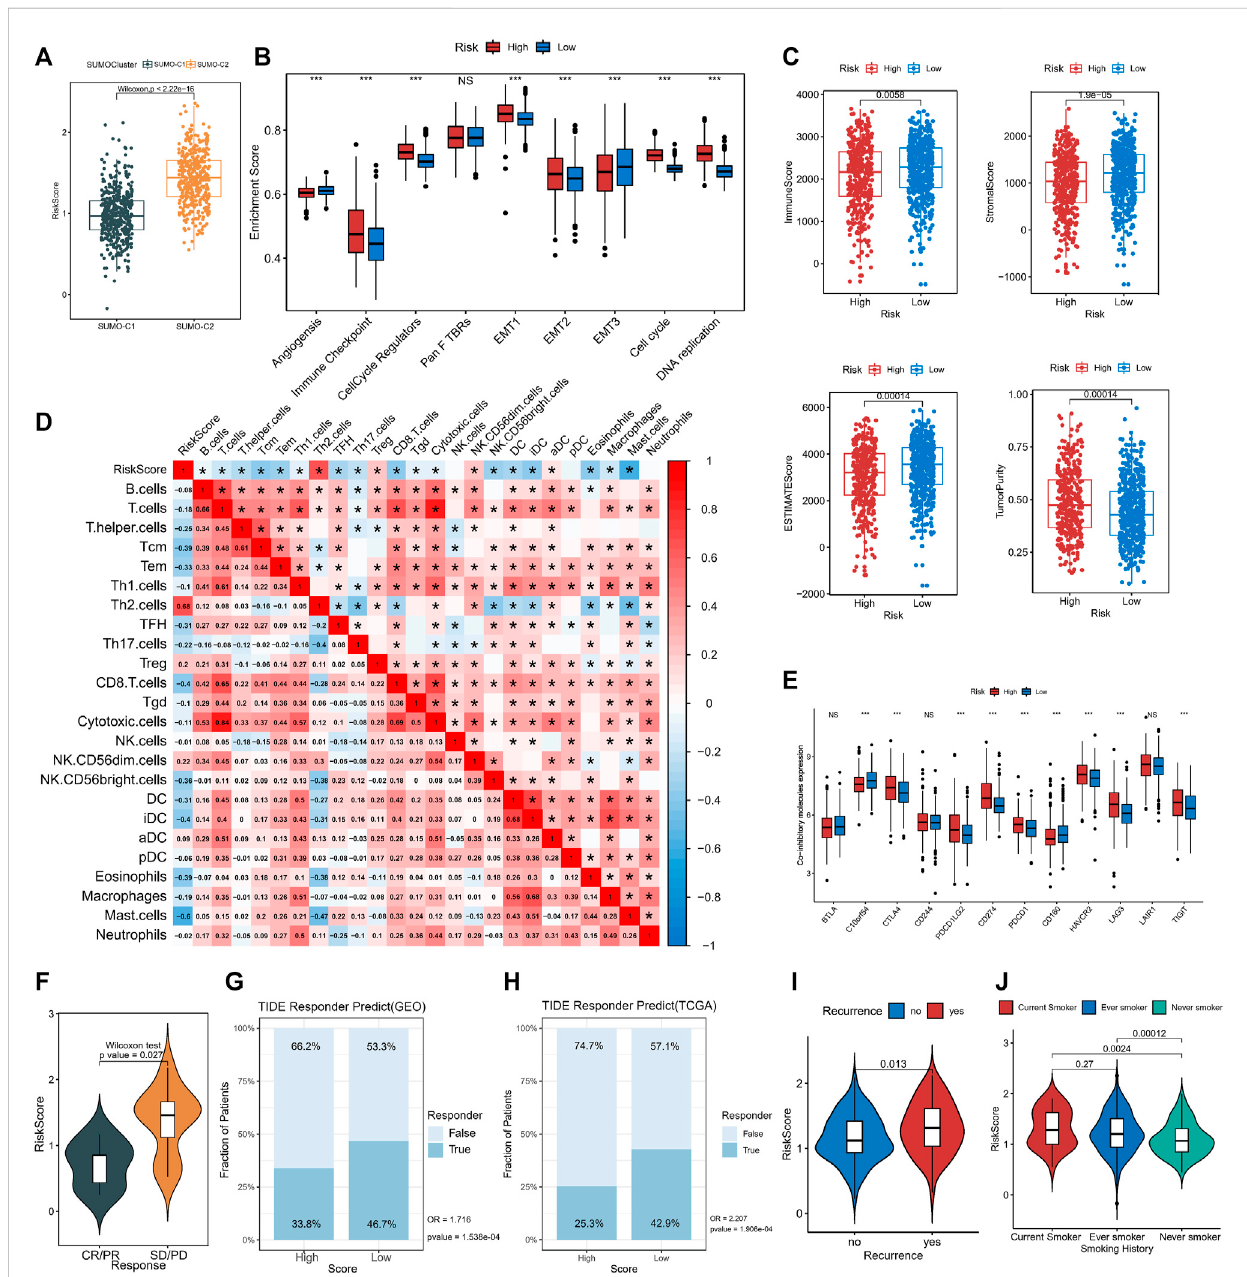
FIGURE 7 The association of SUMOylation score with tumor microenvironment and clinical characteristics. (A) The Wilcoxon test for signi fi cant differences in SUMOylation scoresbetweenthetwoSUMOylation patterns. (B) Oncogenicmatrixmicroenvironmentdifferencesbetweenhigh-andlow-SUMOylation score. (C) Signi fi cant differences in ImmuneScore, StromalScore, ESTIMATEScore, and TumorPurity between different SUMOylation scores. (D) The correlation between SUMOylation score and immune cell in fi ltration. (E) Analysis of differential expression of co-inhibitory molecules between high- and low-SUMOylation score. (F) Comparison of SUMOylation scores between groups with and without immunotherapy response. Prediction of immunotherapy response in high and low-risk groups in GEO cohort (G) and TCGA cohort (H) based on TIDE algorithm. Association of lung adenocarcinoma recurrence (I) and smoking history (J) with SUMOylation